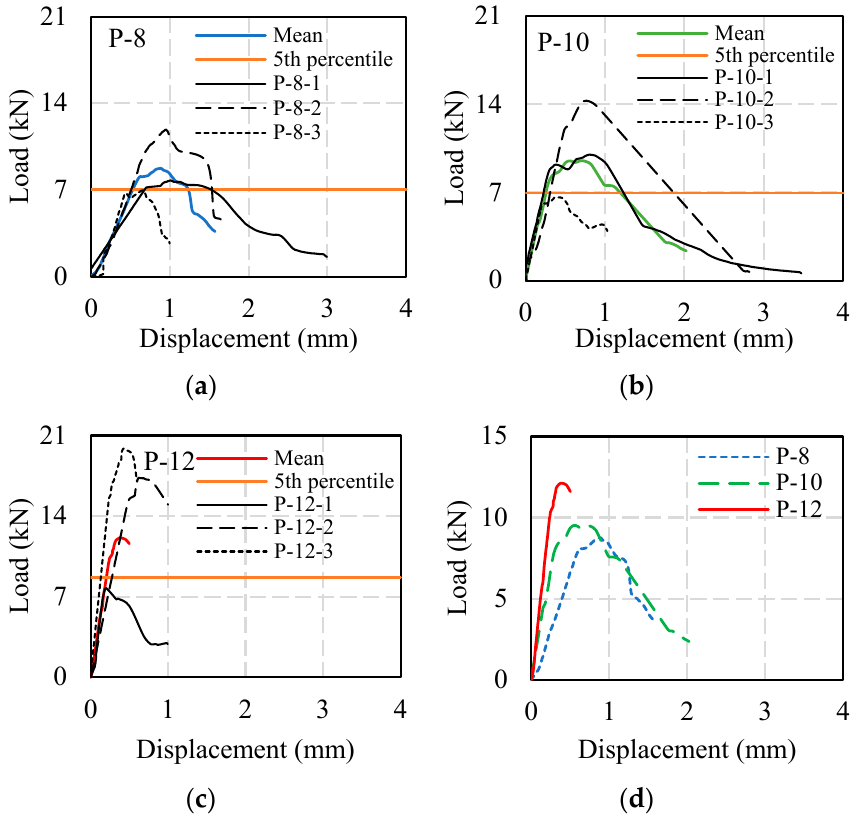
Figure 10. The load-displacement diagram of the pullout test. ( a ) Specimen with M8 bolt; ( b ) specimen with M10 bolt; ( c ) specimen with M12 bolt; ( d ) comparison between three types of specimens.